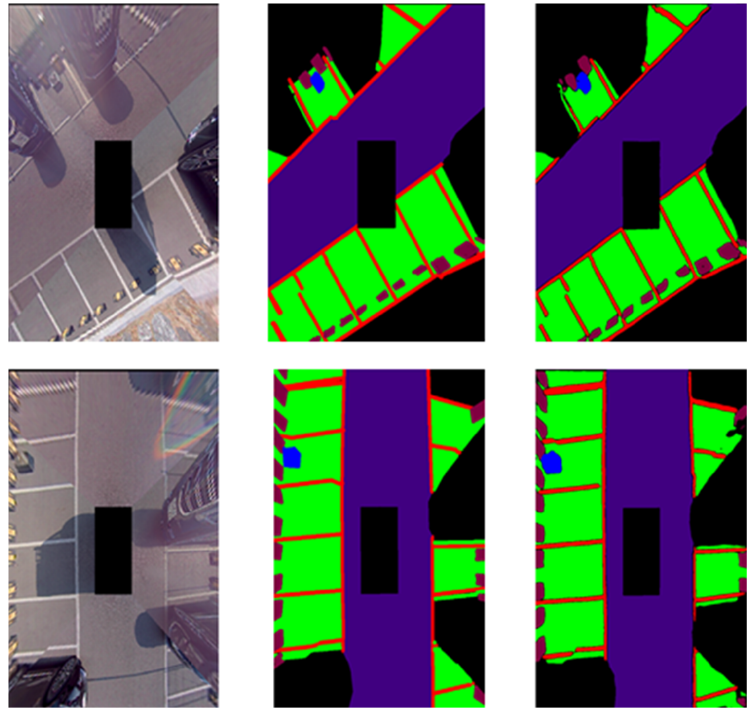
Figure 10. Outdoor semantic segmentation detection results. Left: input; middle: ground truth; right: output.